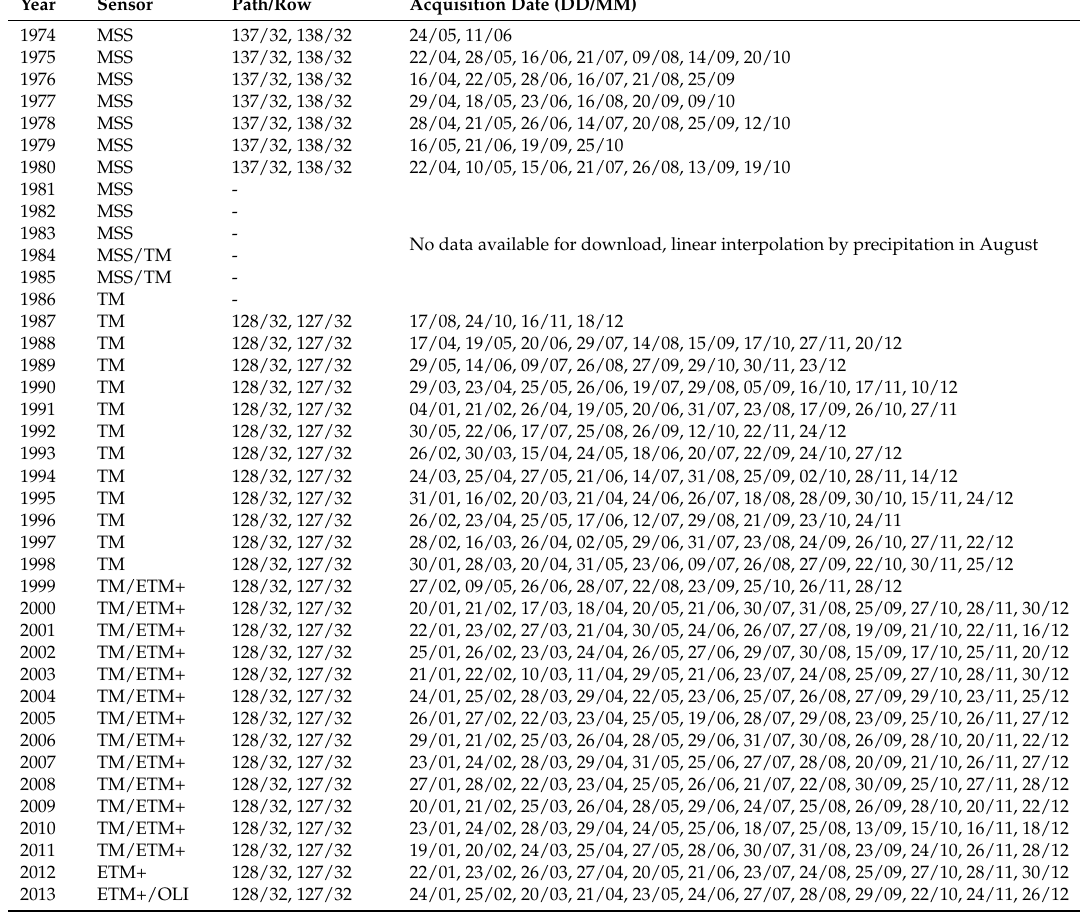
Table 1. Information of used remote sensing images in the Bojiang Lake basin during